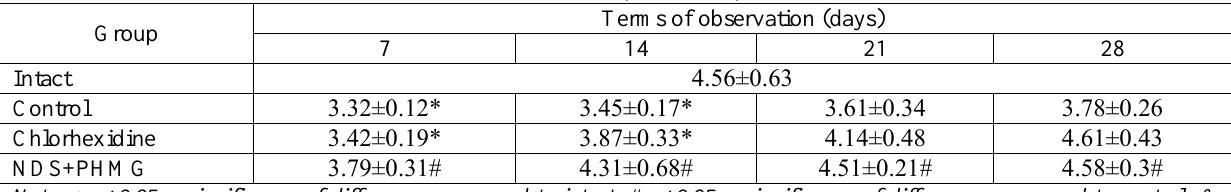
Effect of NDS + PHMG composite and chlorhexidine on SOD activity (conventional units) in the lesion in rats